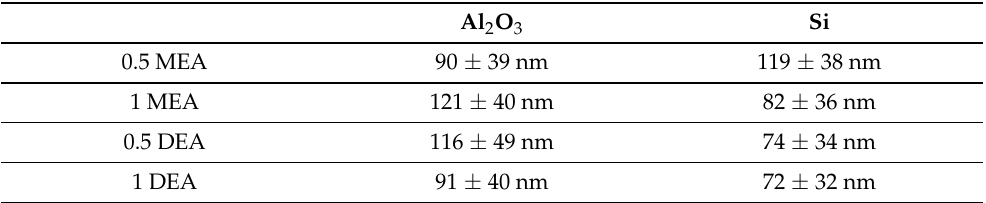
Table 1. Mean crystallites lengths (in nm) and standard deviation estimated from SEM micrographs for ZnO layers grown on specific